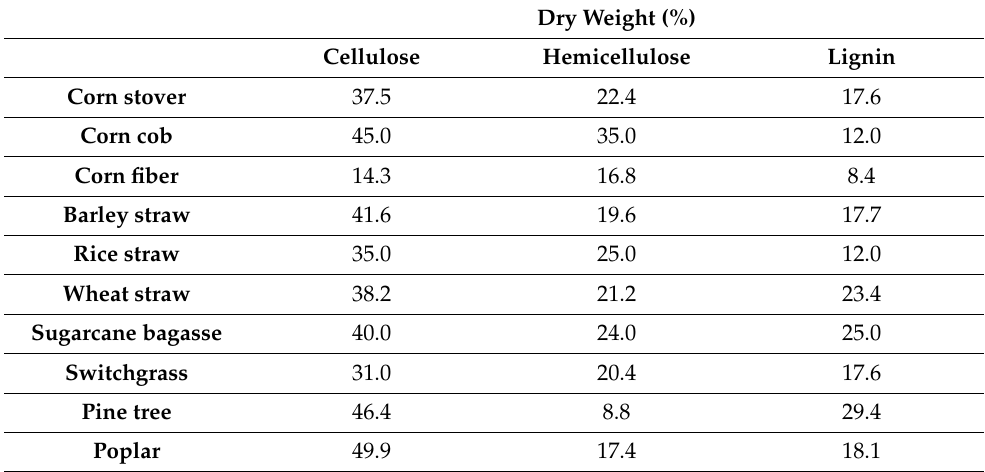
Table 2. Composition of cellulose, hemicellulose, and lignin in terrestrial lignocellulosic feedstock